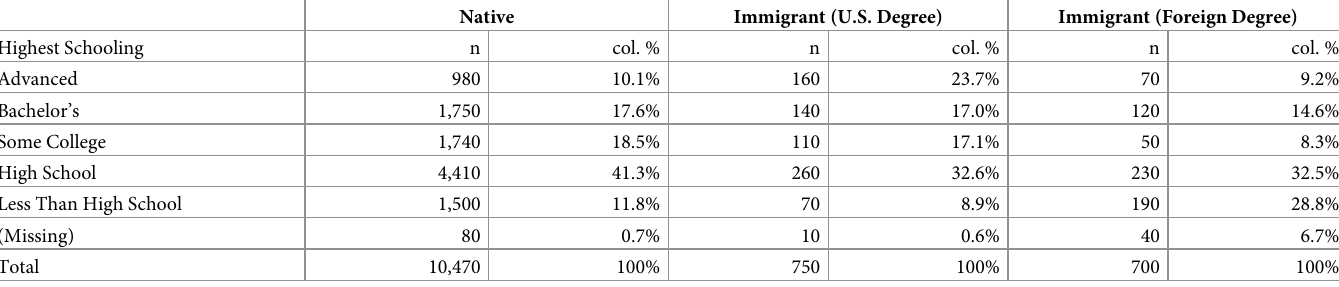
Table 1. Educational distribution of test-takers with valid PIAAC scores.